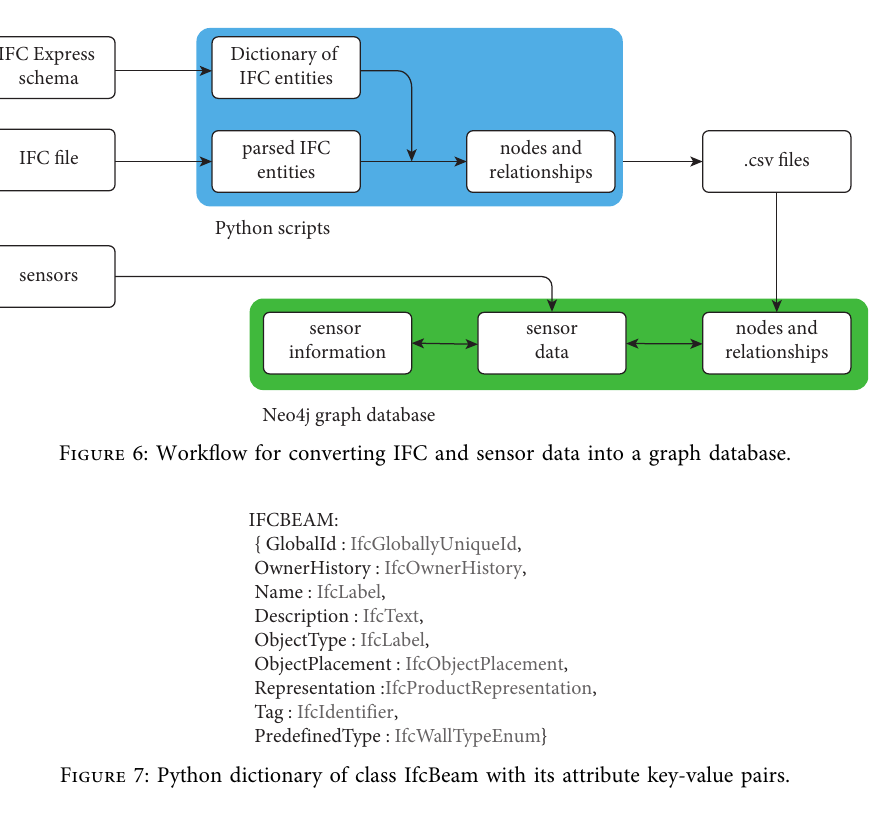
Figure 5: Graph data model for the sensor and its measurements.